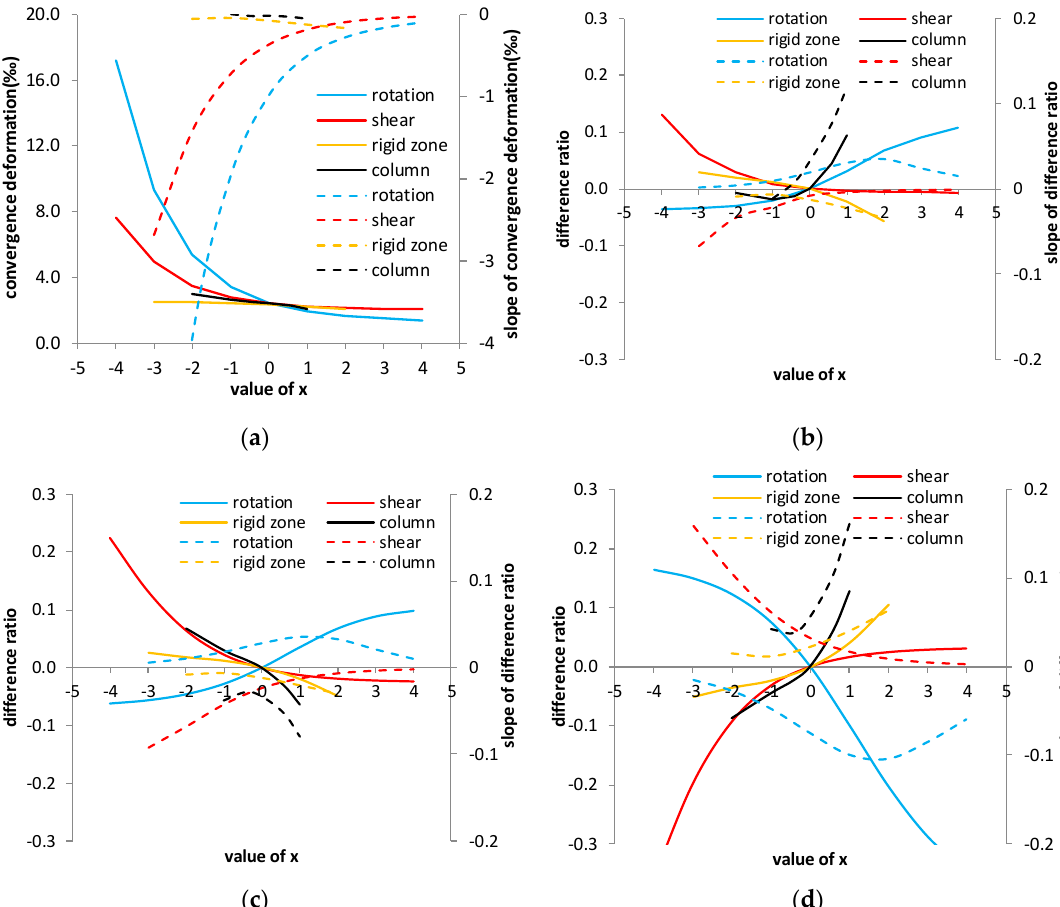
Figure 17. Results of parameter analysis: ( a ) deformation of D3; ( b ) bending moment at JM2; ( c ) bending moment at JM8; ( d ) bending moment at JM10.